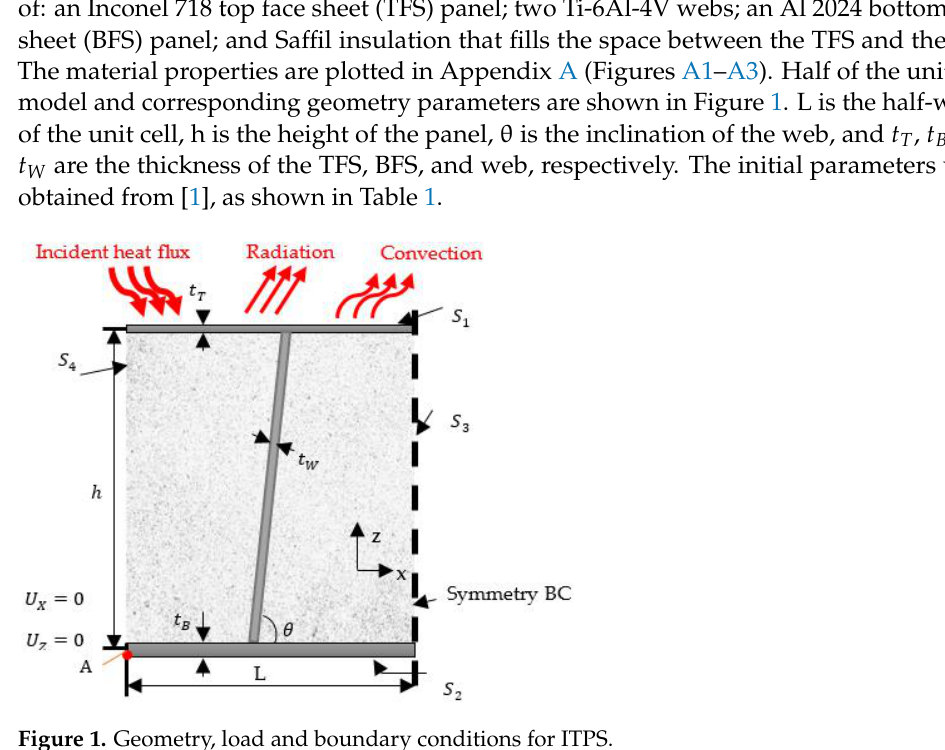
Table 1. Parameters of referenced ITPS panel.